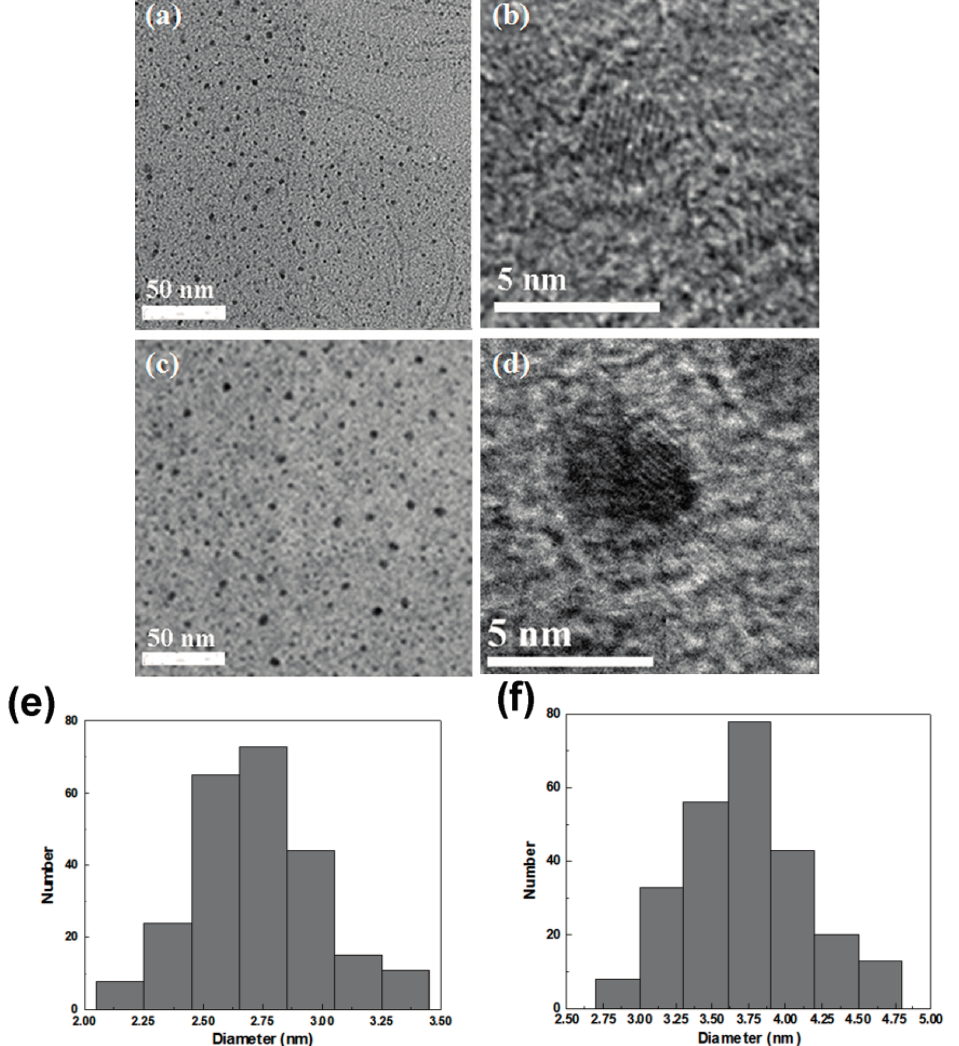
Figure 2. ( a ) Transmission electron microscopy (TEM) and high-resolution (HR)-TEM images of CdTe core ( a , b ) and GSH-CdTe/CdSe core/shell ( c , d ) QDs; Particle size distributions analysis of CdTe core ( e ) and GSH-CdTe/CdSe core/shell ( f )